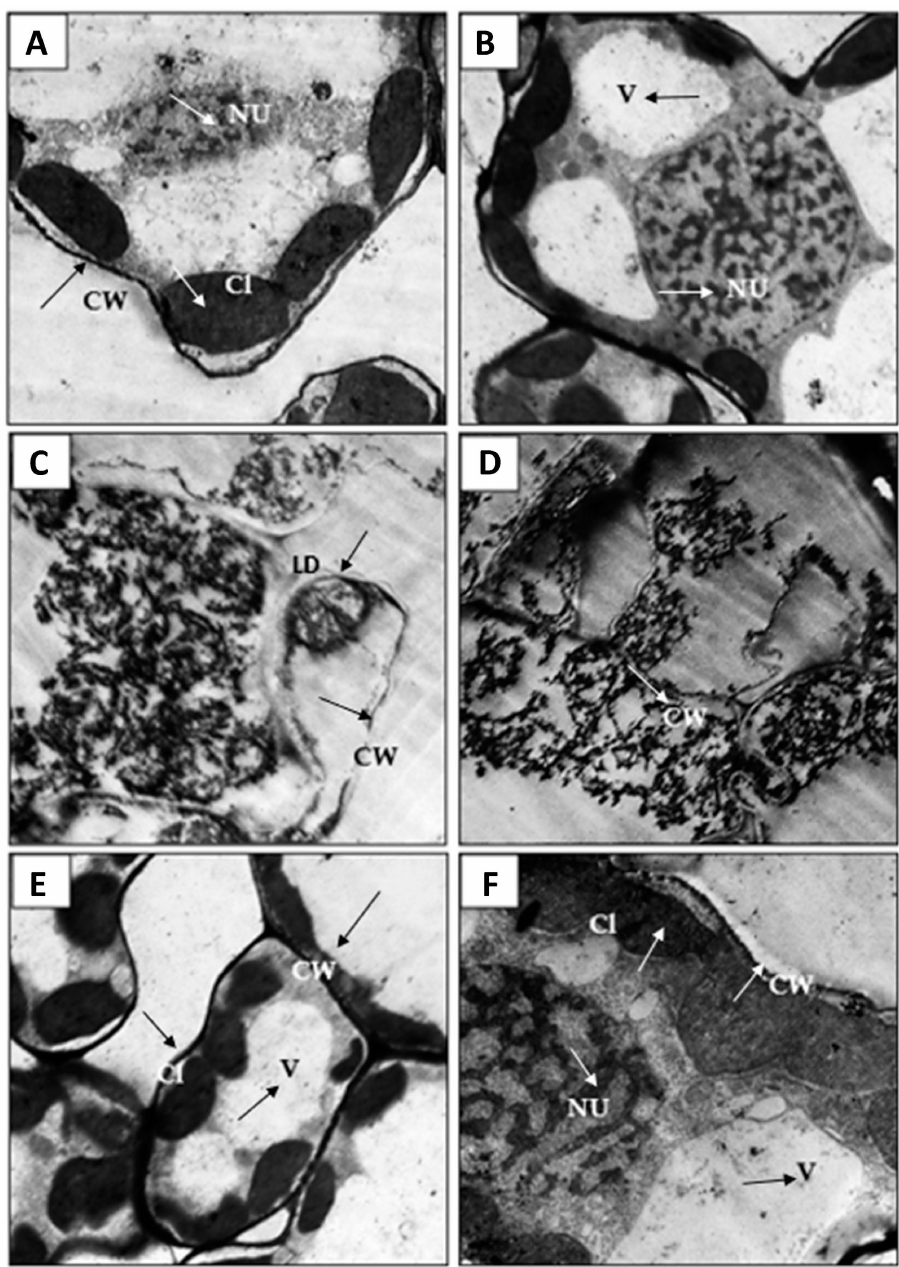
Figure 9. Ultra-micrograph sections of corn ( Zea mays L.) showing leave cells, healthy ( A,B ), where thickened cell wall (CW) is clear compared with untreated, infected. There was a noticeable lack in the differentiation (LD) of the cells, cracking, and lysis in the cell wall and destruction in the nucleus ( C,D ); also, a presence of thickening in the cell wall (CW) was noticed in treated sample ( E , F